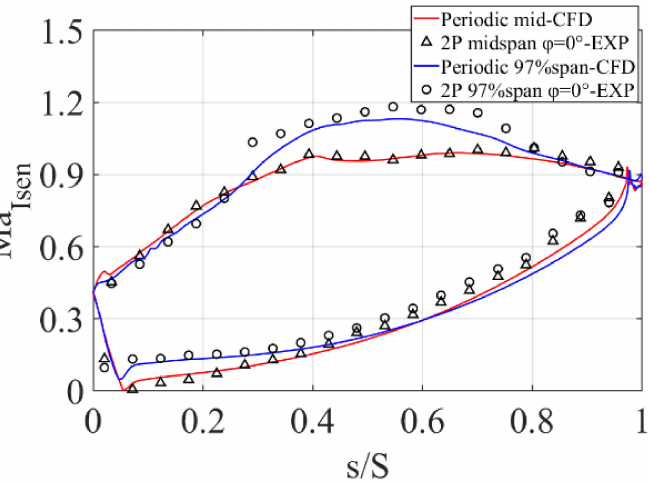
Figure 15. Test blade isentropic Mach number distribution of midspan and 97% span for the test blade at stationary condition (CFD and EXP).